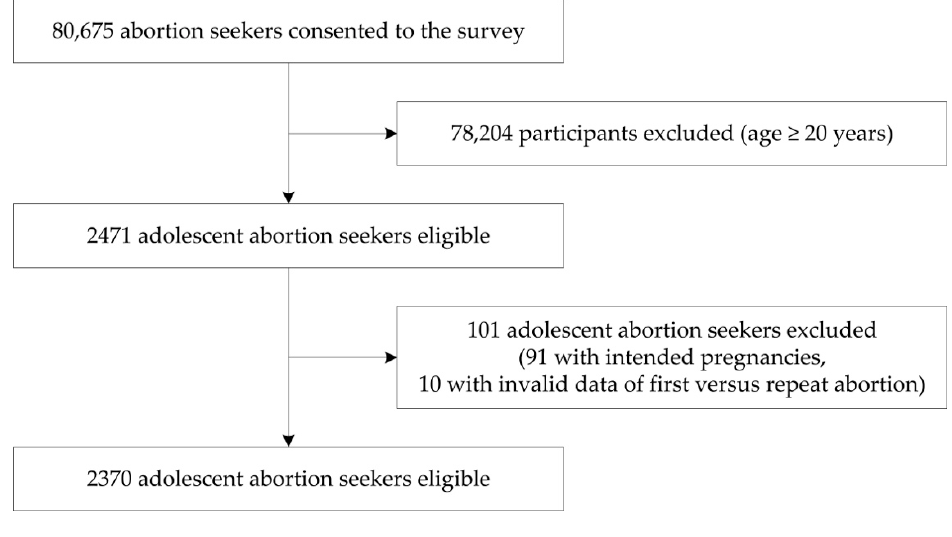
Figure 1. Study profile.